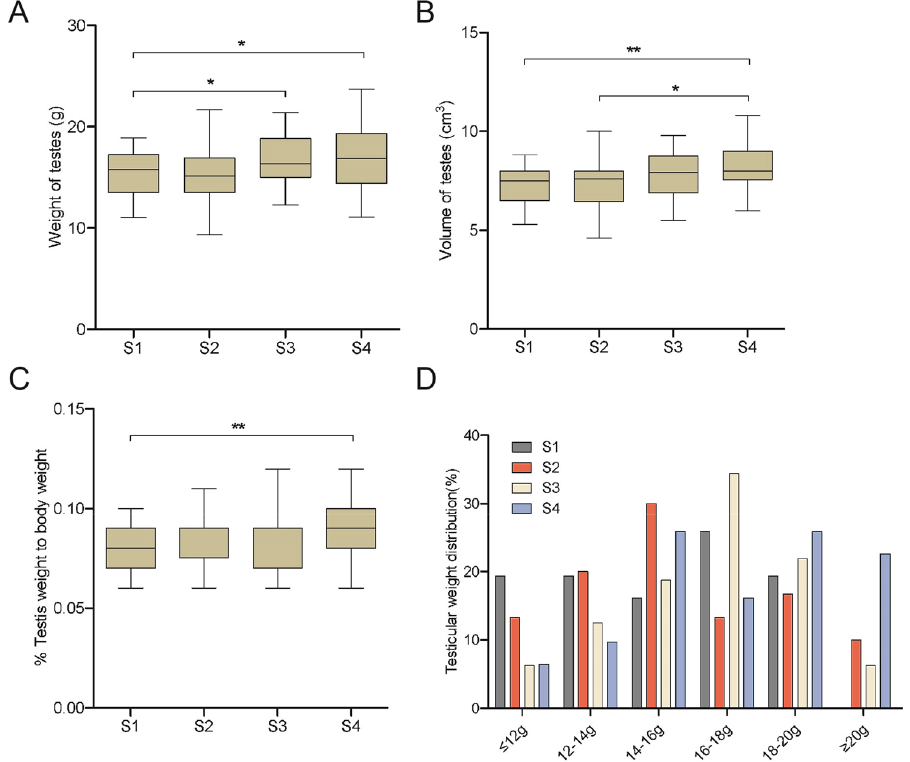
Figure 1. Data analysis of testicular development phenotype traits of piglets. ( A ) Testicular weight in g at 82 days of age. ( B ) Testicular volume in cm 3 at 82 days of age. ( C ) Testis to body weight ratio at 82 days of age. ( D ) Testicular weight distribution for each treatment. The values shown are the means ± SEM (Significant difference: * P < 0.05; ** P < 0.01; *** P < 0.001). S1: control diet; S2: control diet supplemented with 1 μg/kg 1α,25(OH) 2 VD 3 ; S3: control diet supplemented with 2 μg/kg 1α,25(OH) 2 VD 3 ; S4: control diet supplemented with 4 μg/kg